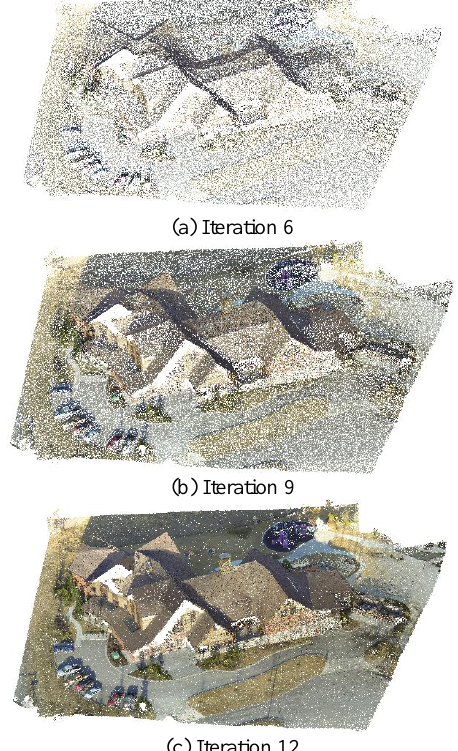
Figure 6. (a – c) Progressive dense reconstruction outcome